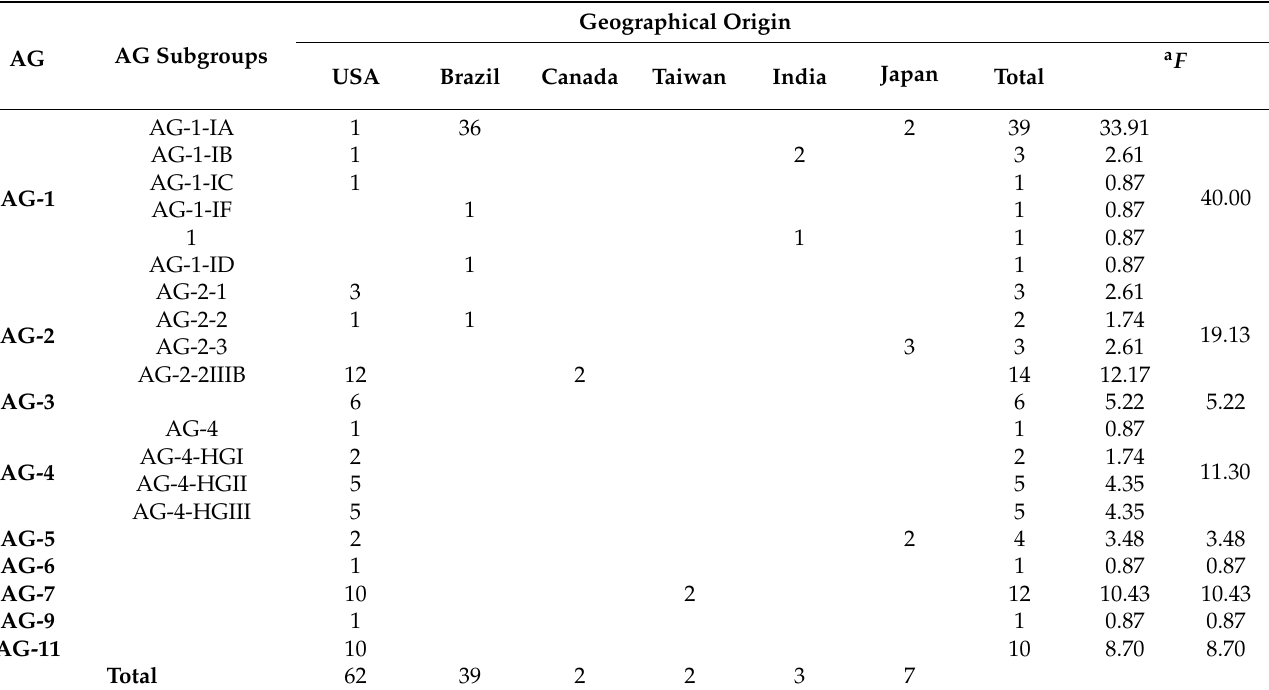
Table 1. Frequency of R. solani AG associated with soybean across the geographical